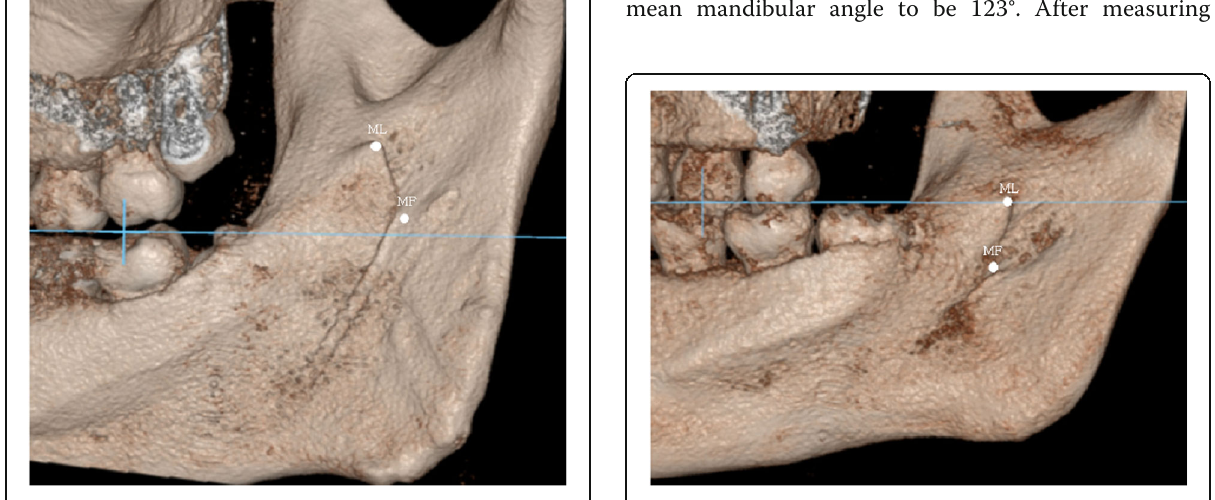
Fig. 5 ML at the level of occlusal plane; MF below the occlusal plane; MF in front of ML. The blue line indicates the occlusal